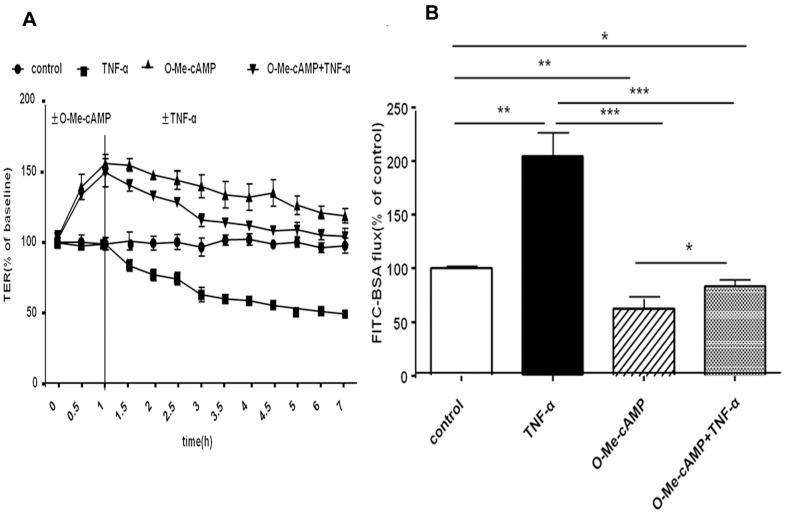
Effect of increased Rac1 activity on TNF-α-induced hyperpermeability of the primary RPMVEC monolayer.A: Effect on TER of the primary RPMVEC monolayer. Compared with controls, TER of primary RPMVEC monolayer challenged with TNF-α for 2 hours decreased significantly. Pretreatment of the primary RPMVEC with O-Me-cAMP (1 hour) significantly augmented TER and prevented TNF-α-induced the drop of TER. B: Effect on flux of FITC-BSA across the primary RPMVEC monolayer. Compared with untreated cells, the RPMVECs treated with TNF-α for 2 h had higher levels of FITC-BSA flux, whereas O-Me-cAMP treatment alone resulted in decrease FITC-BSA flux. Co-treatment with O-Me-cAMP and TNF-α [i.e., O-Me-cAMP +TNF-α] did not lead to increased endothelial permeability. Each bar represents mean ±SD of four independent trials; * denote P<0.05, ** denote P<0.01, *** denote P<0.001.